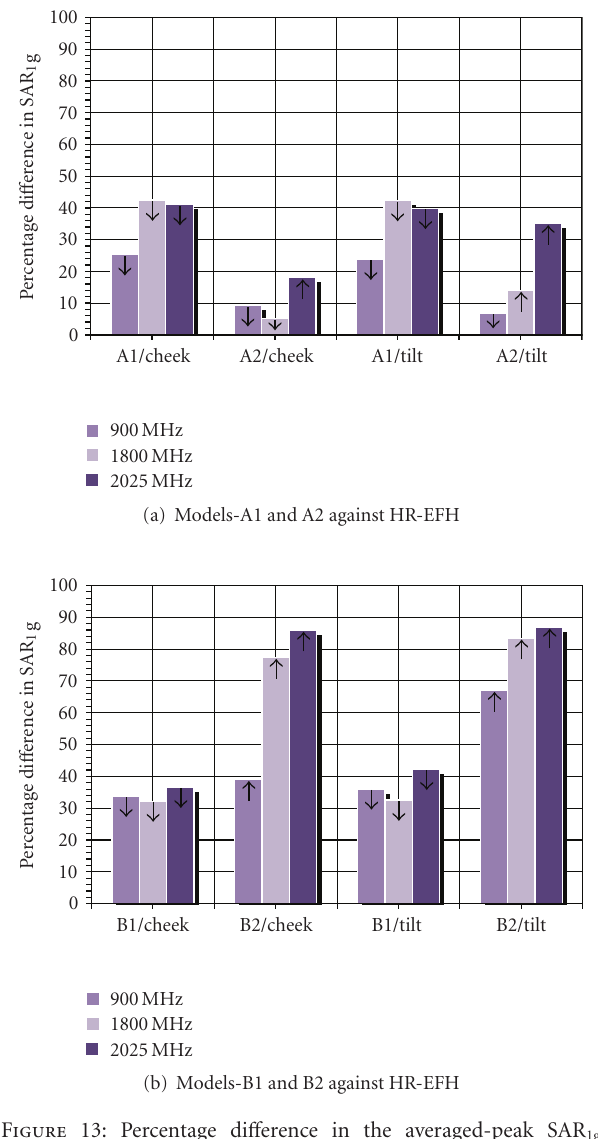
Figure 13: Percentage di ff erence in the averaged-peak SAR 1g values in HR-EFH, owing to hand-hold alteration, at dif- ferent antenna/handset positions in GSM900, GSM1800, and